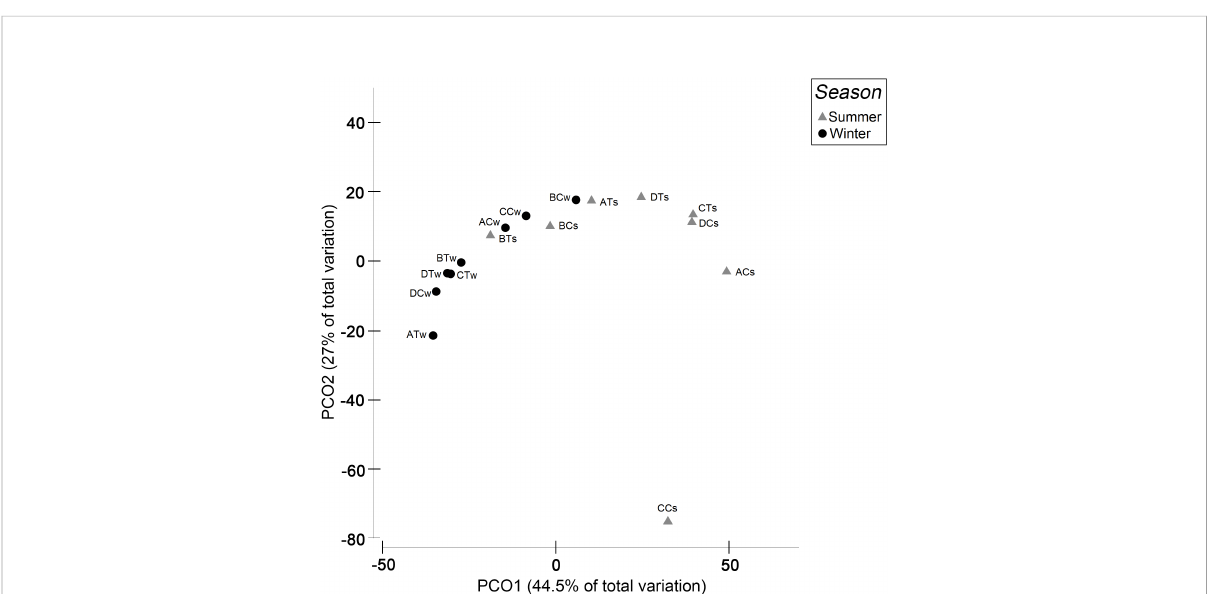
FIGURE 5 Principal coordinate analysis (PCoA) of weighted biological traits with square-root transformed biomass for treatments (AT-DT = trawled sites, AC-DC = non-trawled sites) and seasons (s, summer; w,